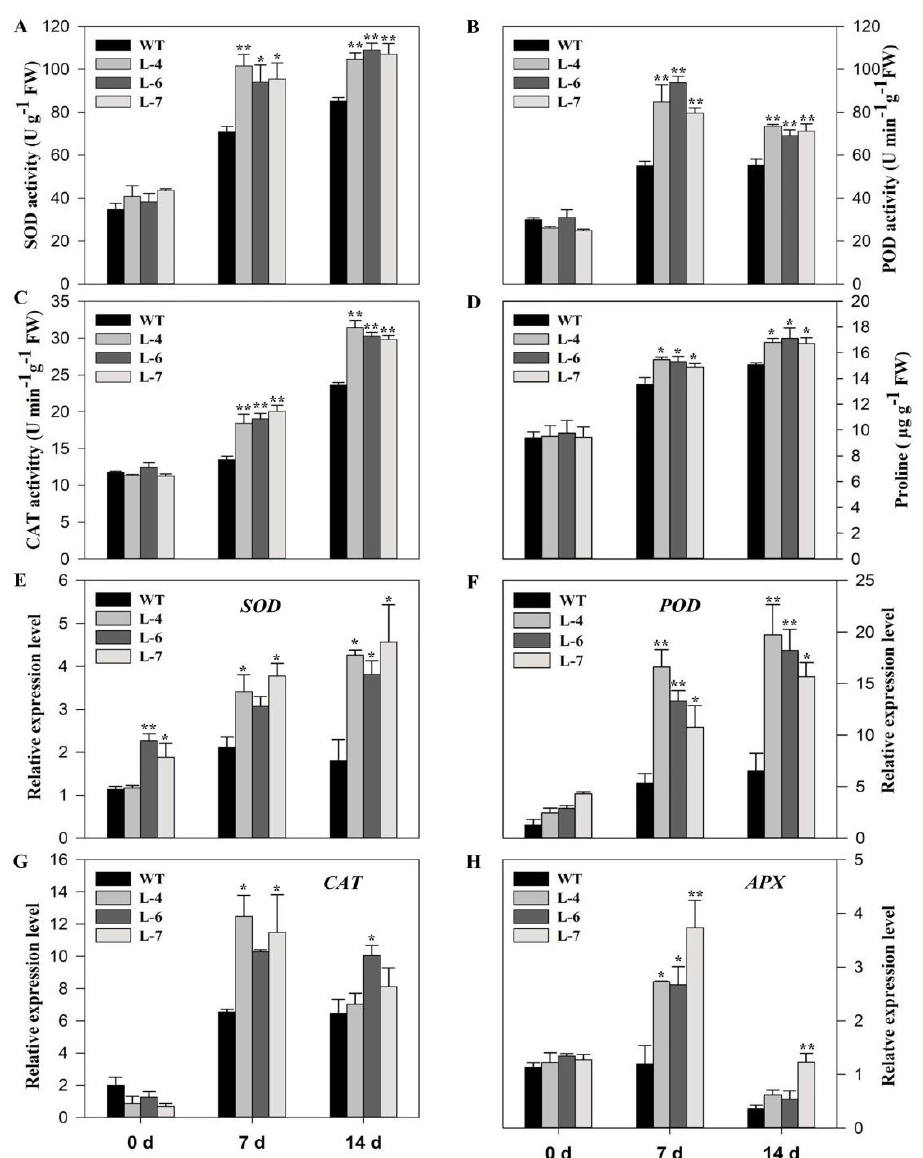
Figure 6. Antioxidant enzymes activities and transcript level of related genes in WT and transgenic lines under cadmium stress. ( A – C ) Activities of SOD, POD and CAT respectively. ( D ) Proline content and expression analysis of ( E ) SlSOD , ( F ) SlPOD , ( G ) SlCAT , and ( H ) SlAPX . Seedlings of transgenic lines and WT at five leaf stage were treated with 0 (0 days) and 100 µ M (7- and 14-days) cadmium. Data represent mean ± SE of three biological replicates. **, * significant level differed at p < 0.01 and p < 0.05, respectively.